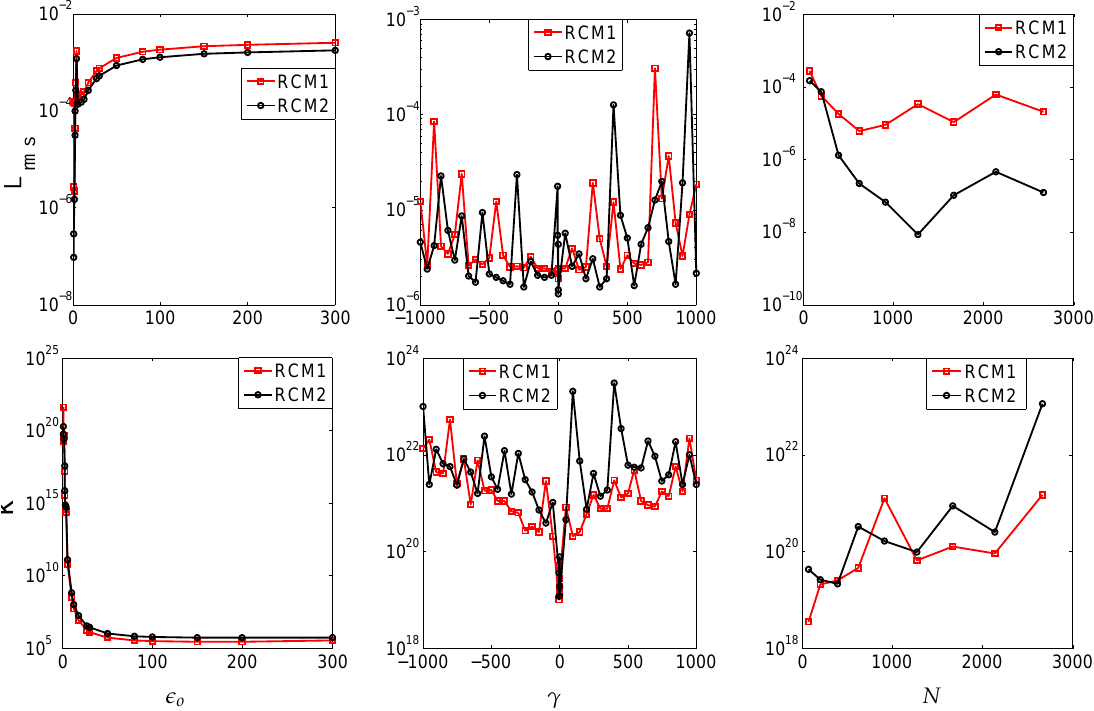
Figure 6. Test Problem 2, accuracy and κ versus (cid:101) o , γ , and N : ˆ Γ 1 = 94, ˆ Γ 2 = 46, γ = 1, (cid:101) o = 2, and N = 320 when its influence is